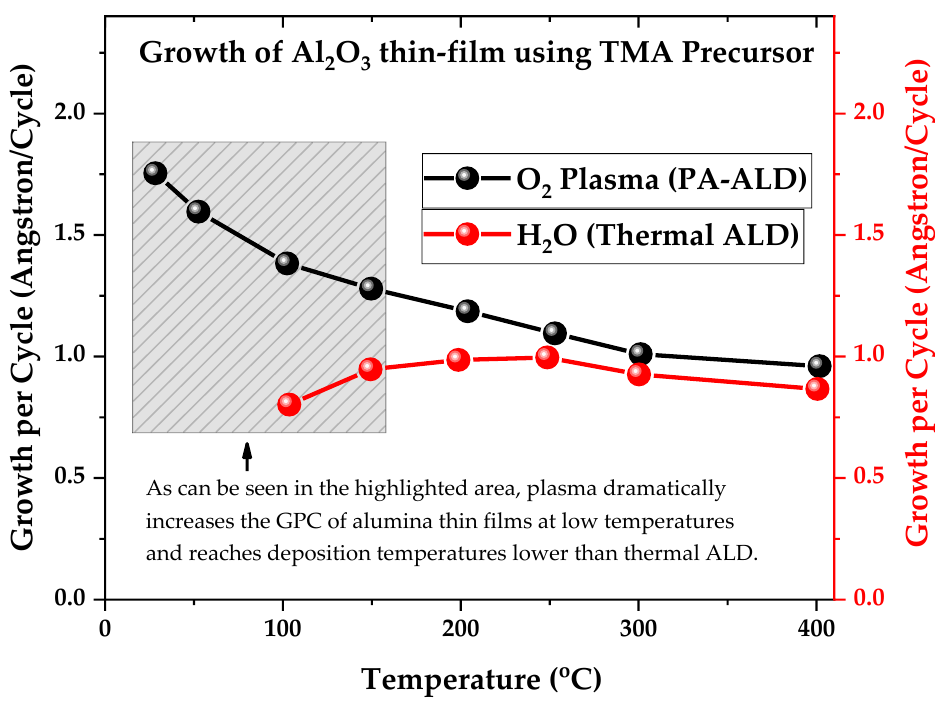
Figure 5. Growth per cycle of Al 2 O 3 thin films as a function of substrate temperature for both types of ALD reactors, respectively, plasma-assisted atomic layer deposition (PA-ALD) and thermal atomic layer deposition (ALD). Figure adapted with permission from Ref. [57].